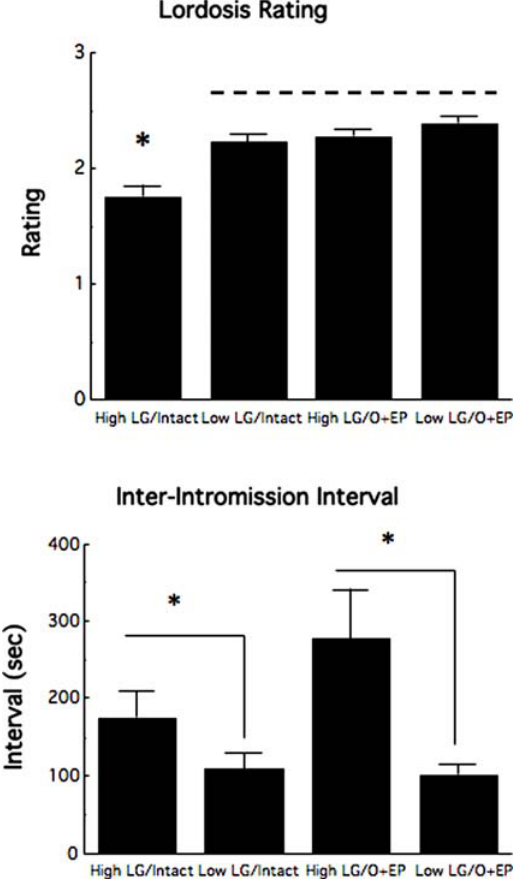
Figure 5. Effect of ovariectomy and steroid treatment in the sexual behavior of the female. Mean 6 SEM lordosis rating or inter- intromission interval in the adult female offspring of Low or High LG mothers tested with a stud male in the pacing chamber arena (n=7– 10/group) either intact (at proestrus) or following ovariectomy with E2B + progesterone replacement. For the lordosis rating data, groups lying underneath the line differ significantly ( p , 0.05) from the High LG/intact group such that the maternal effect is apparent among intact animals, but not ovariectomized animals with a common level of steroid replacement. For the inter-intromission interval data, the maternal effect is apparent (* p , 0.05) among both intact and ovariectomy/ steroid-primed conditions.